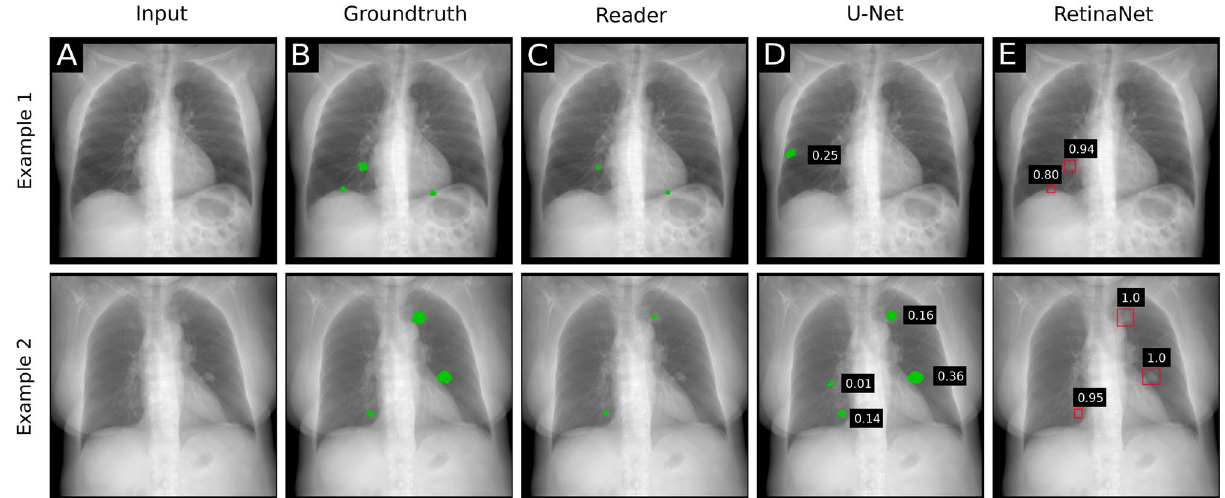
Figure 1. Synthetic radiographs, ground truth masks and results of reader and computer-based detection. ( A ) Synthetic input radiograph as shown to the reader and evaluated by the CNNs ( B ) corresponding ground-truth radiograph with nodules marked green ( C ) center position of nodules marked by a reader ( D ) U-Net prediction ( E ) RetinaNet bounding-box predictions with